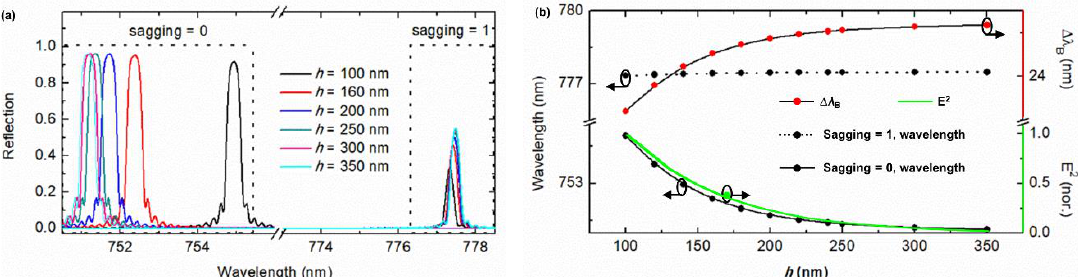
Figure 5. ( a ) Spectra and ( b ) λ B , ∆ λ B and mode field intensity E 2 of the third order Bragg grating as a function of the pillar height h .